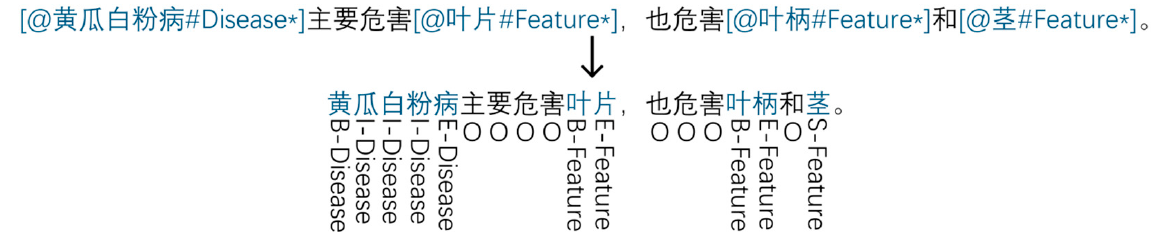
Figure 6. An example of named-entity recognition labeling. Example “ 黄瓜白粉病主要危害叶片, 也 危害叶柄和茎 ” (this means that the cucumber powdery mildew mainly harms the leaves, as well as the petioles and stems).